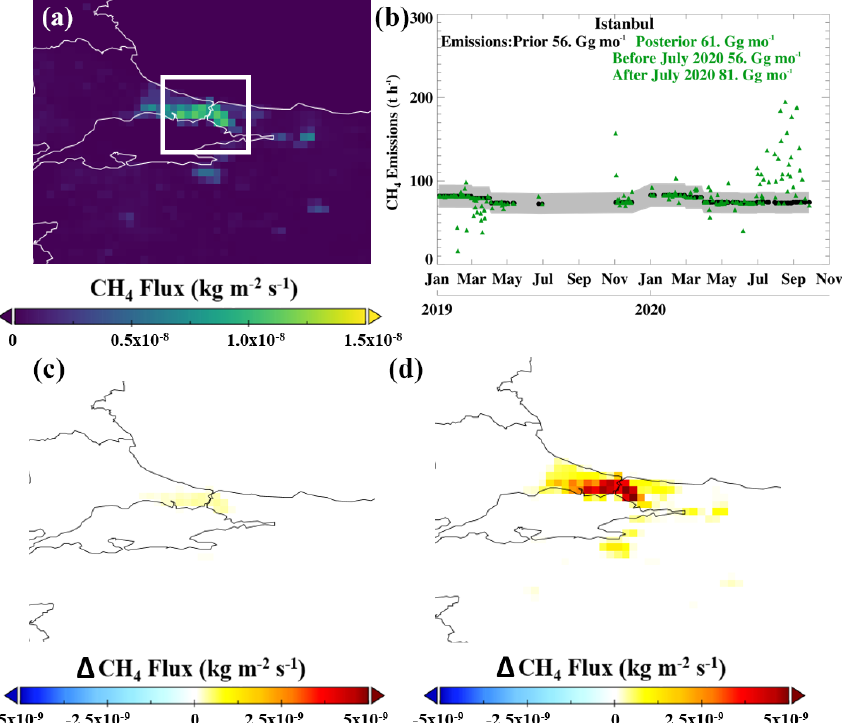
Figure 10. (a) Prior CH 4 emissions within the Istanbul domain for September 2020. (b) Time series of total prior (black circles) and posterior (green triangles) CH 4 emission estimates within the 1 ◦ × 1 ◦ domain, centred around 41 ◦ N, 29 ◦ E (white box in a ) for 2019–2020, where observation and inverse simulations are available. The shaded error denotes prior uncertainty. Average posterior minus prior CH 4 emissions for May (c) and September (d) 2020, using dates where nearby observations were available.